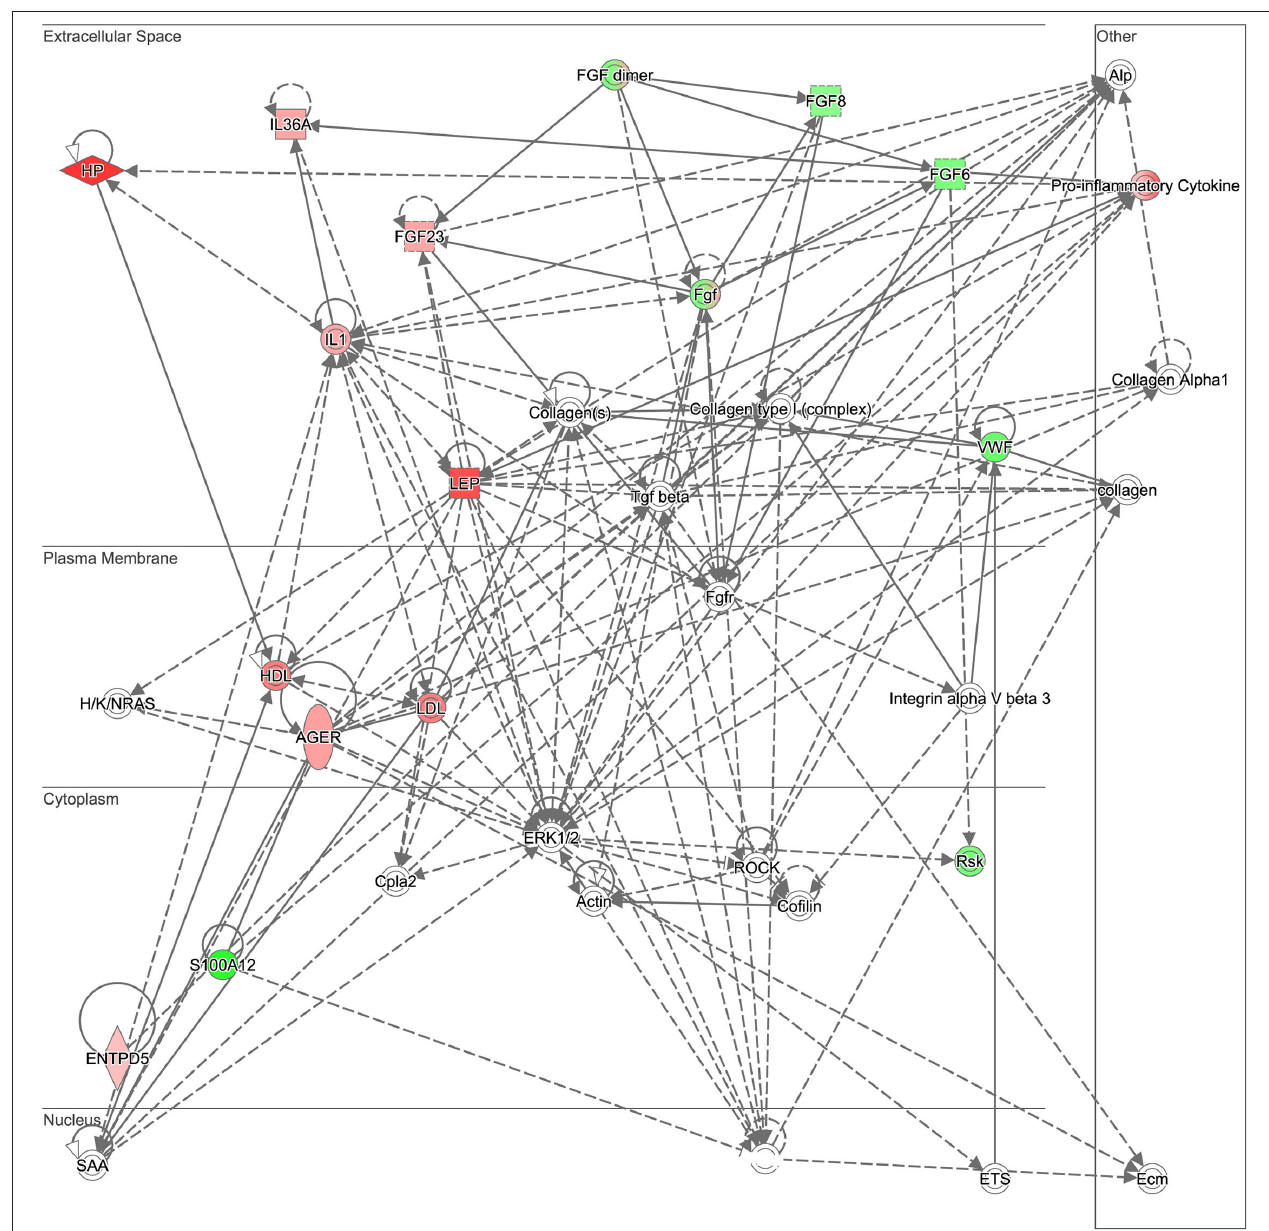
FIGURE 1 | Ingenuity Pathway Analysis (IPA) mechanistic network. Top Ingenuity Pathway Analysis (IPA) mechanistic network analysis revealed the protein-protein interaction in the network associated with Hepatic System Development and Function, Cellular Movement, and Organismal Injury and Abnormality. Green indicates that the protein is downregulated and red indicates that the protein is upregulated, with increased color saturation representing more extreme measurement in the dataset. Proteins in gray indicate the direct relationship with differential expression proteins in the network. Solid lines indicate direct interaction and dashed lines indicated indirect